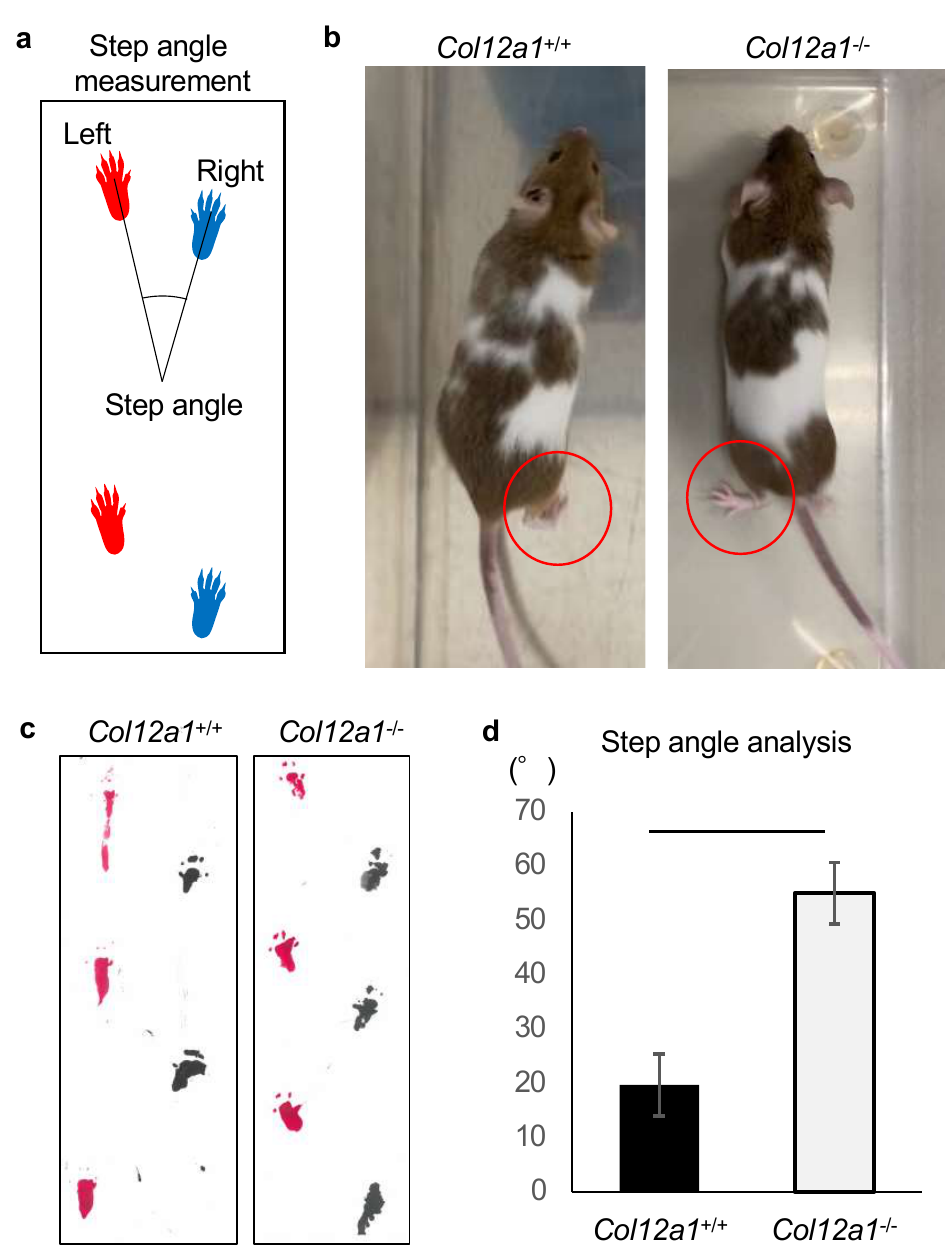
Figure 1. Gait abnormality in Col12a1 deficient mice. ( a ) The method diagram for measuring the step angles from the footprints. ( b ) Images of gait analyses for wild-type control ( Col12a +/+ ) and Col12a1 -/- mice at 4-week-old. The control mouse lifted its heel (red circle), whereas the heel of the Col12a1 -/- mouse was down, and the foot was positioned outward (red circle). ( c ) Representative footprints from wild-type control and Col12a1 -/- mice are shown. ( d ) The step angle was statistically larger in the Col12a1 -/- mice compared with wild-type controls ( p < 0.01).